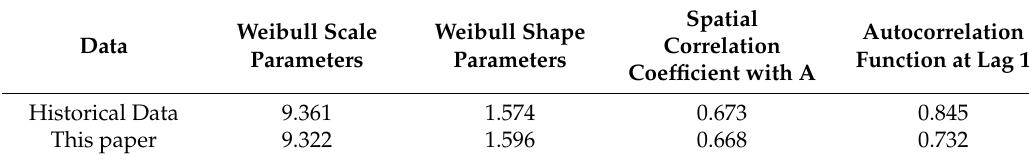
Table 2. Comparison on generated wind speed simulation data.